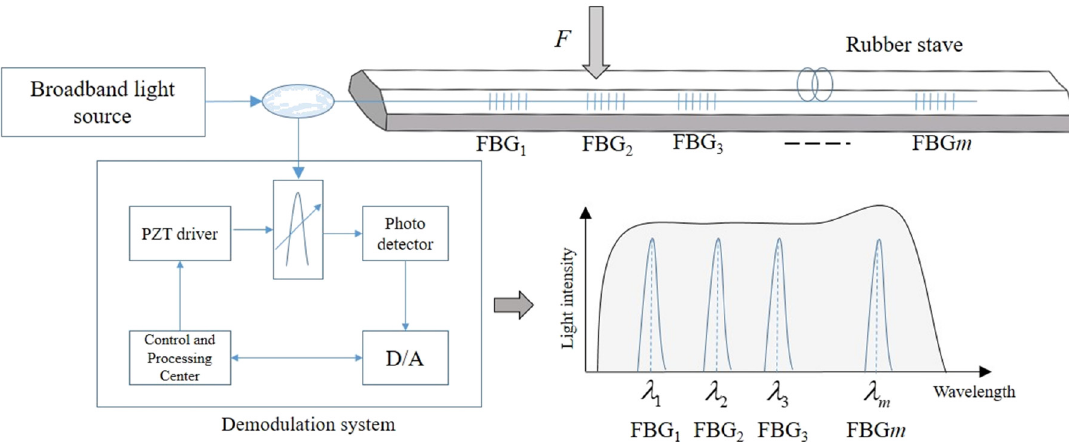
Figure 5: Wavelength assignments for the FBG multi - point strain monitoring system.